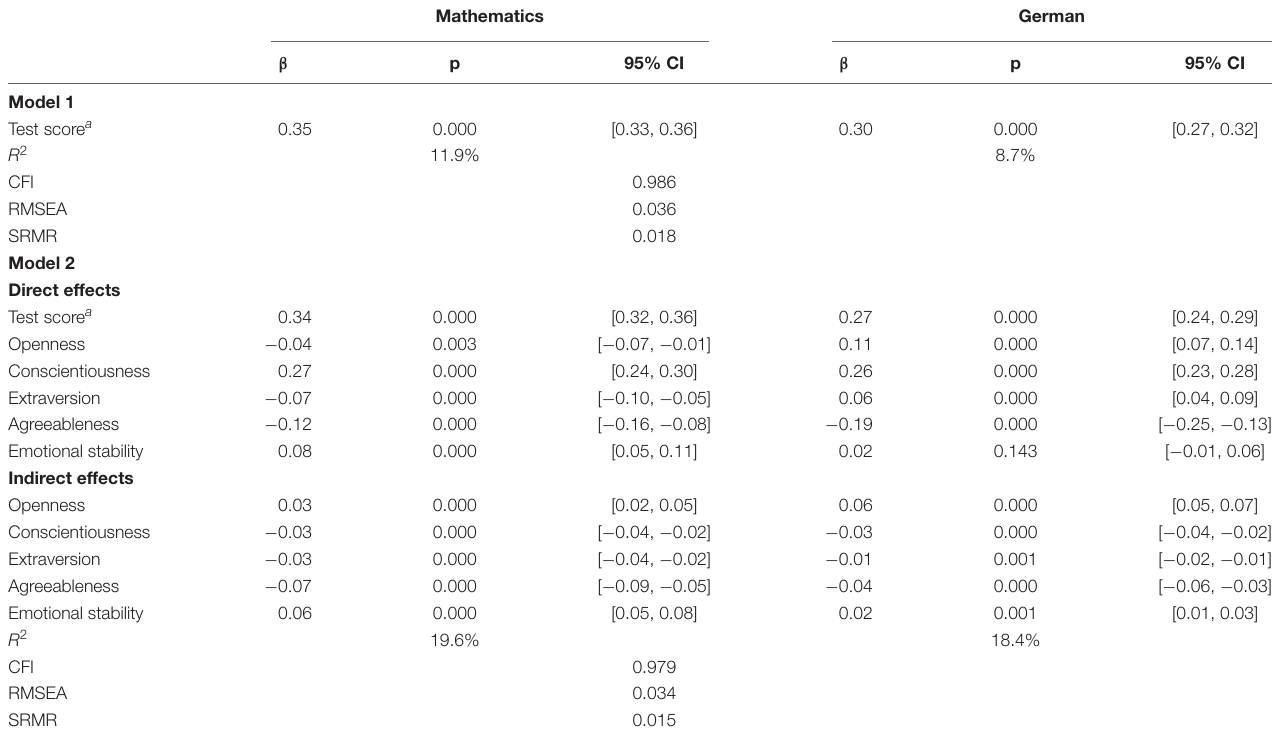
TABLE 2 | Predicting teacher-assigned grades in mathematics and